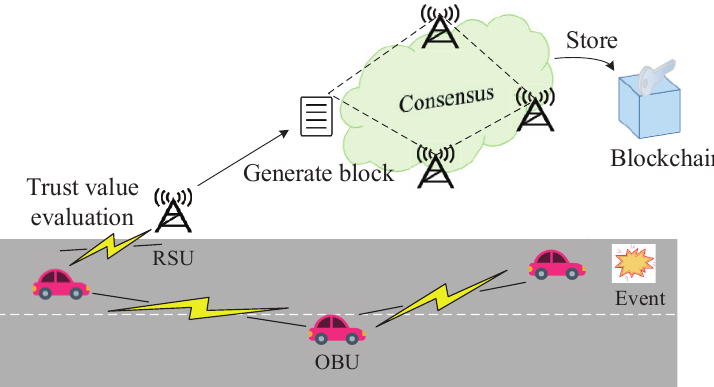
Figure 6. Trust Evaluation Model of IoV Based on